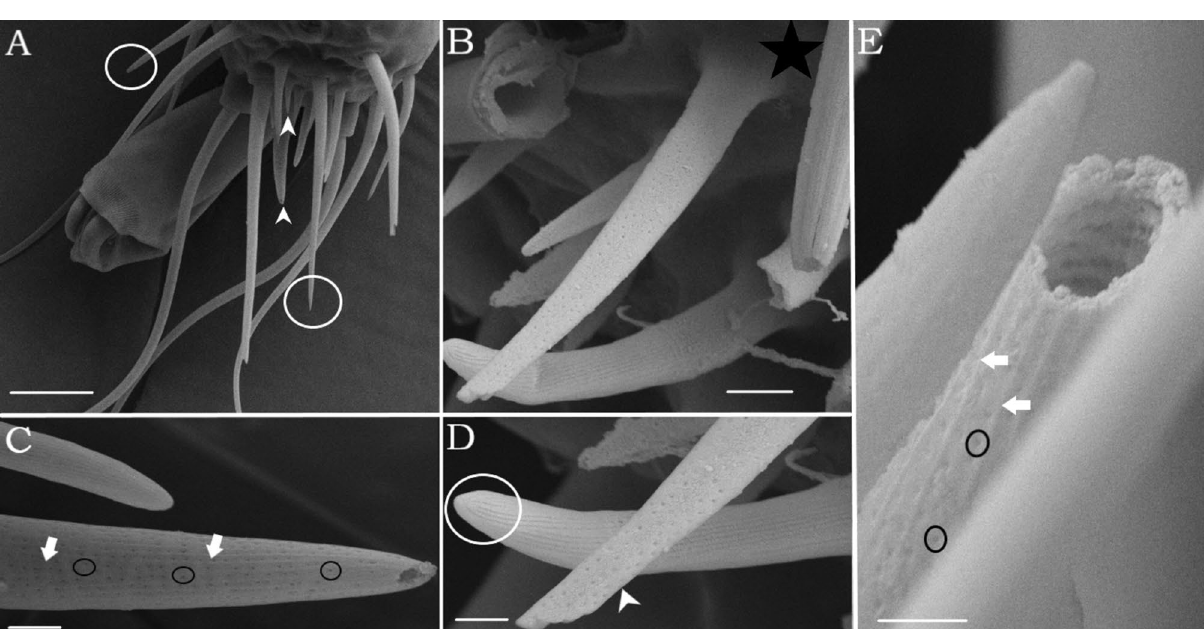
Figure 2. SEM of sensilla chaetica with wall-pores (Sc-wp). ( A ) Lateral view of different types of hair sensilla on the distalmost tarsus (DT-I), circles indicate Sc-tp and arrowhead indicate Sc-wp sensillum ( B ) Structure of socket with an incomplete articulation (white square) ( C ) Shaft with longitudinal ridges (white arrows) and numerous pores housed in longitudinal grooves (black circle) ( D ) Comparing tip pore (circle) and wall pore sensilla (white arrows) ( E ) White arrows represent longitudinal ridges, and circles indicate lines of wall pores. Scale-bars : ( A ), 10 μm, ( B ) 2 μm, ( C ) 1 μm, ( D , E ), 200